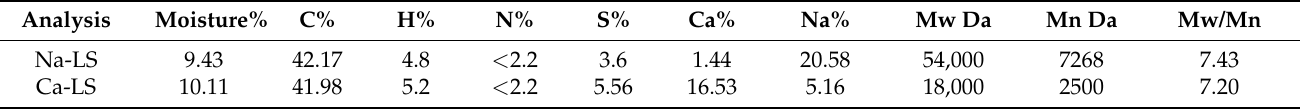
Table 5. Elemental analysis, molecular mass of lignosulfonates samples used in the